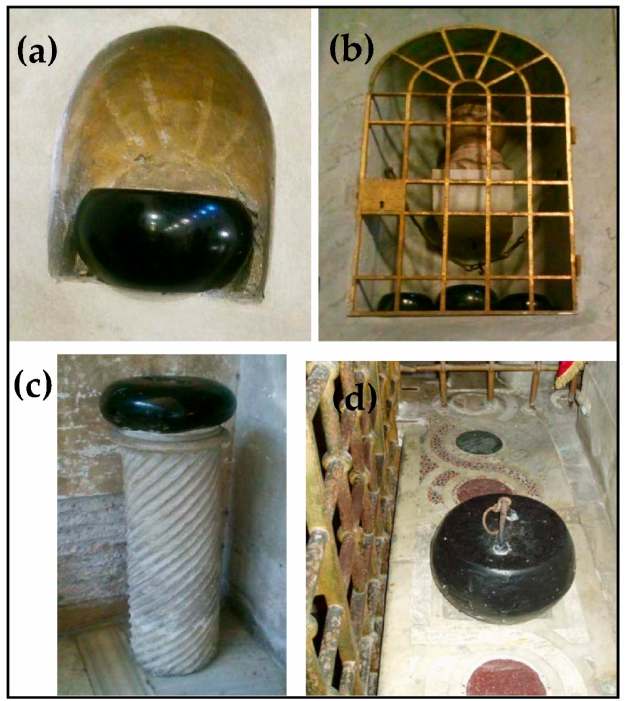
Figure 5. Some Lapis Martyrum hosted in different churches of Rome; ( a ) Santa Maria in Cosmedin; ( b ) Santa Maria in Trastevere; ( c ) Santa Sabina; ( d ) San Lorenzo Fuori le Mura (presently